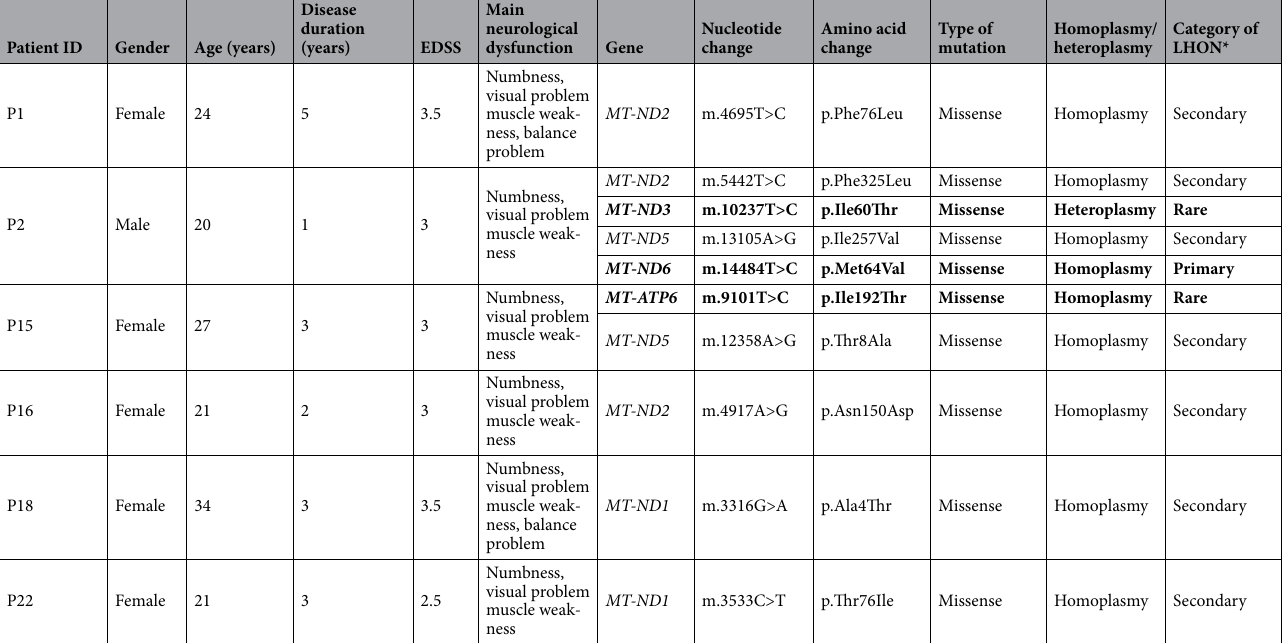
Table 3. Characteristics of RRMS patients carrying LHON mtDNA mutations. RRMS relapse-remitting multiple sclerosis, LHON Leber’s hereditary optic neuropathy, EDSS Expanded Disability Status Scale. *LHON Mutations were reported as primary or rare (bold) and secondary according to MITOMAP, HmtDB, ClinVar and MEDLINE-listed publications on life